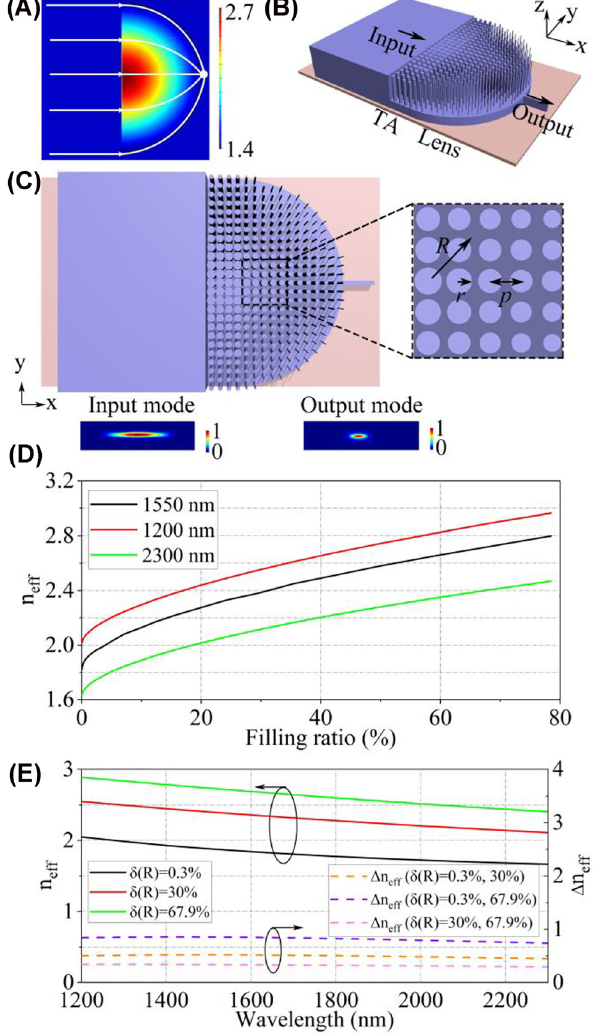
Figure 1: Design of half Maxwell’s fisheye lens. (A) Beam focusing behavior of the lens (B) Schematic of the on-chip half Maxwell’s fisheye lens. (C) Xy -plane view of the lens and magnified view of the nanorods array. (D) Relationship between the calculated effective ) and the filling ratios ( 𝛿 ( R )) of nanorods. (E) Relationship index ( n eff between the calculated effective index ( n ) and the wavelength. TA: eff transition